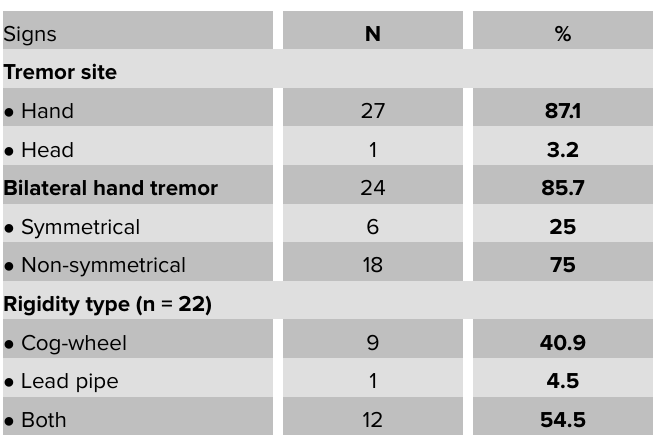
Table 2: The signs of PINK1 early onset PD among the patients.